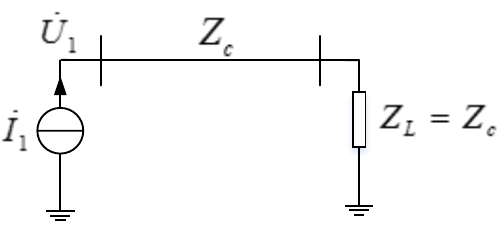
Figure 5. Matching terminal resistor at the earth end.